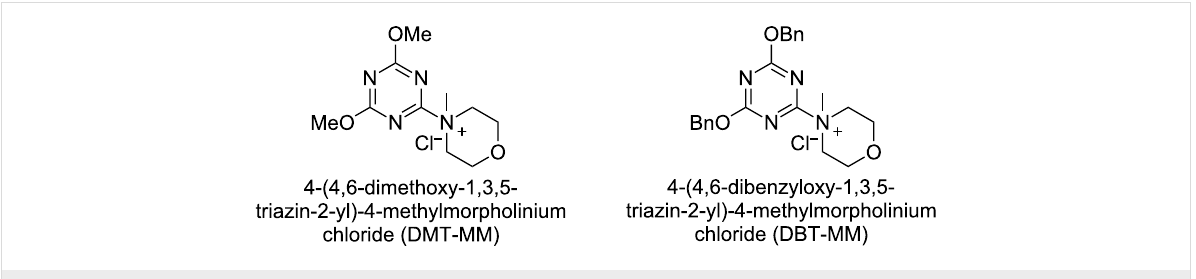
Figure 5: Triazinylmorpholinium salts as selective anomeric activating agents.